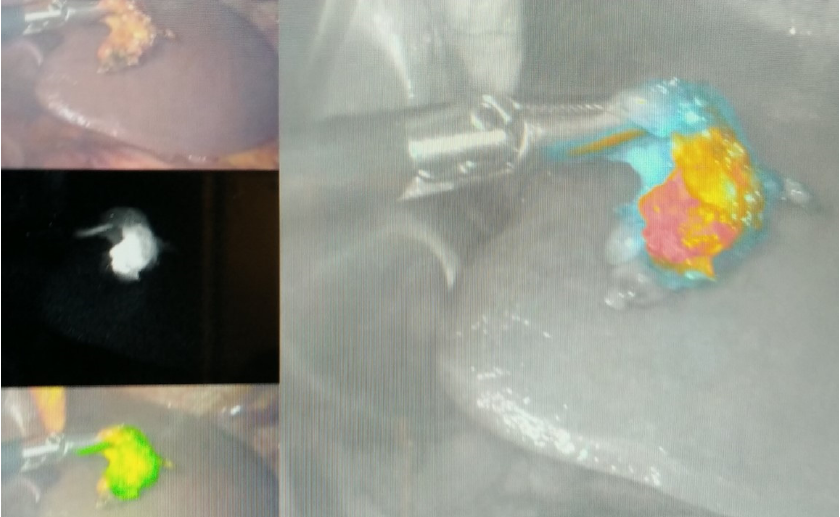
Figure 1. Fluorescence-guided LN dissection in GC patients (Department of Surgical Oncology, Medical University of Lublin).